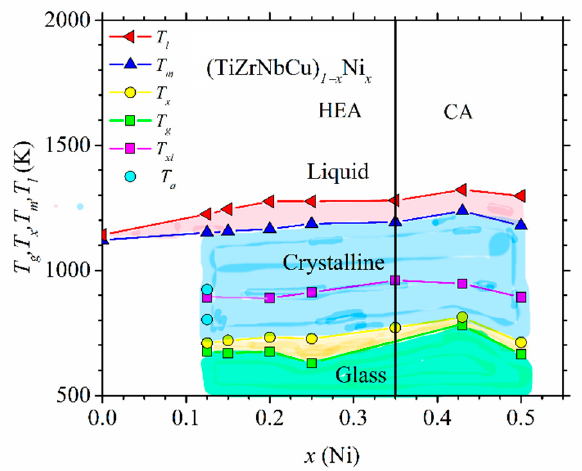
Figure 6. Thermal parameters of (TiZrNbCu) 1 − x Ni x alloys vs. x . T x and T xl denote temperatures of the first and last crystallization events, respectively. T a s denotes annealing temperatures of the alloy with x = 0.125. Different phases are differently colored.